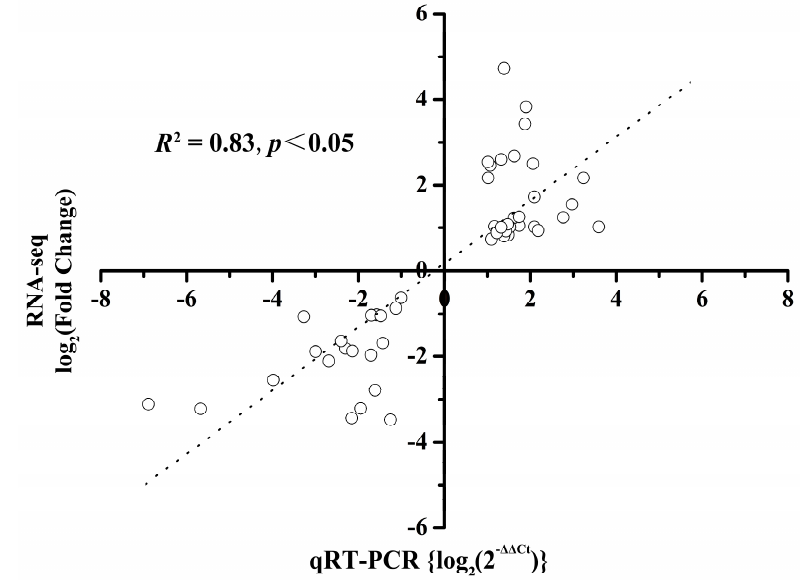
Figure 8. The correlation between qRT-PCR and RNA-seq data. Correlation between qRT-PCR and RNA-seq data of 48 selected DEGs: 28 upregulated genes and 20 downregulated genes in 4 pairs of amplified RNA samples. The dashed line was the fitting curve estimated by correlation analysis, and Spearman Rank Correlation coefficient = 0.83 ( p < 0.05).